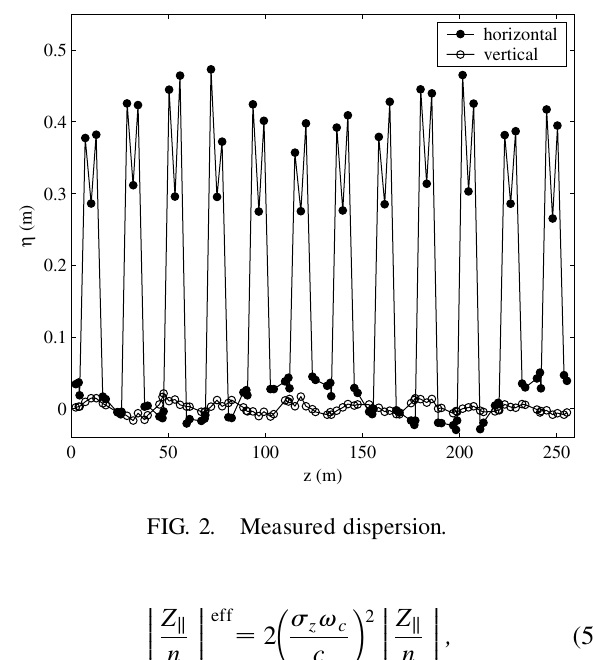
FIG. 2. Measured dispersion.